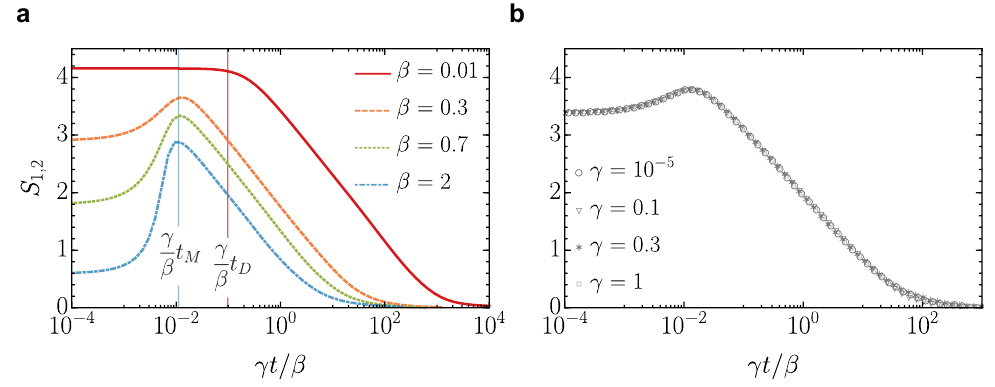
Figure 3 . Rényi-2 entropy of the thermofield double state. Hamiltonian averages of 100 GOE(64) Hamiltonians in rescaled time. a : at high temperature, β → 0 , the Rényi entropies start decaying to zero after time t D . The two copies of the TFD are effectively being disentangled to a product state. At low temperatures, the decay comes after the growth to maximum value around a timescale t M , until which entanglement increases. The two regimes are separated by the critical temperature scale 1 /β c . b : Rényi-2 entropy for β = 0 . 2 . In the rescaled time the structure of the Rényi entropies rely only on the value of β